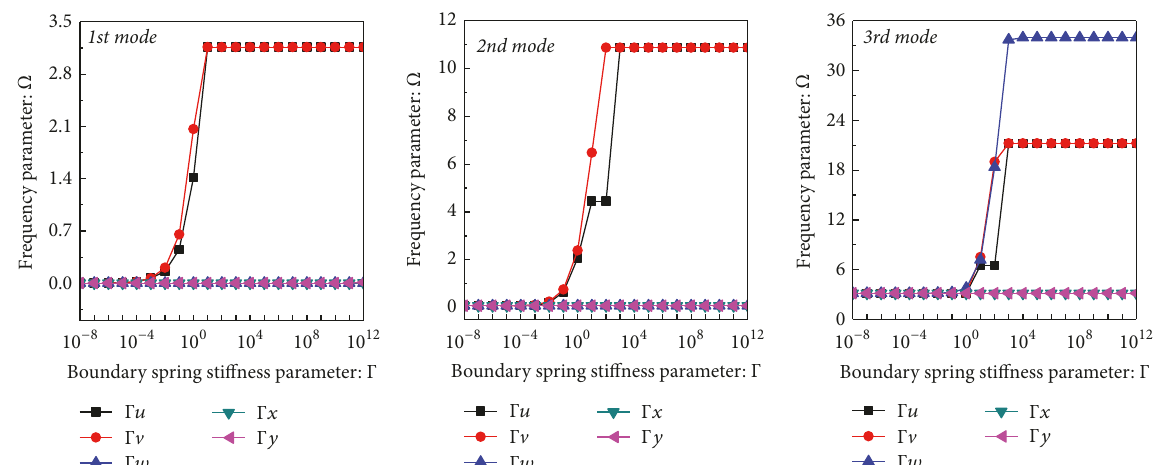
Figure 4: Frequency parameters Ω versus elastic spring stiffness parameter Γ for the plate with uniform boundary.